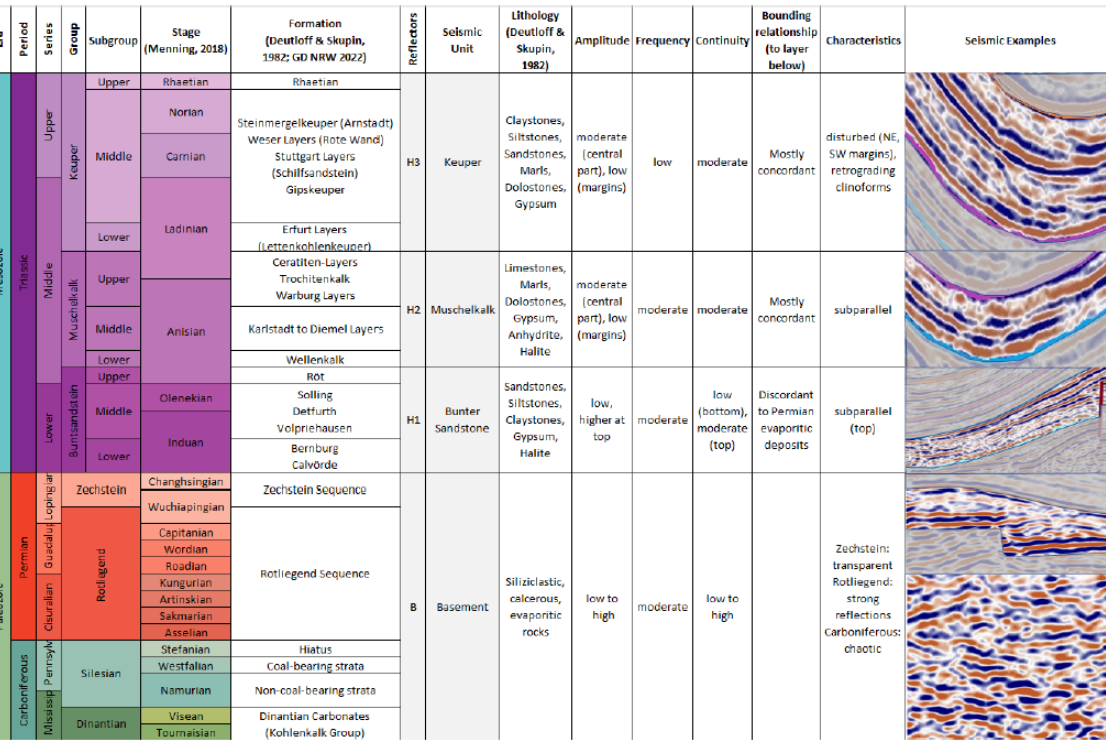
Table 5. Continuation of Table 4. Seismo-stratigraphic concept for this study after Ahlrichs et al. (2020). The table summarizes the nomen- clature for seismic reflectors, the respective seismic units, the lithology according to Deutloff et al. (1982), the characteristics for amplitude, frequency, continuity, bounding relationships and further seismic characteristics including a sample seismic section. The size of individual series do not scale to the true